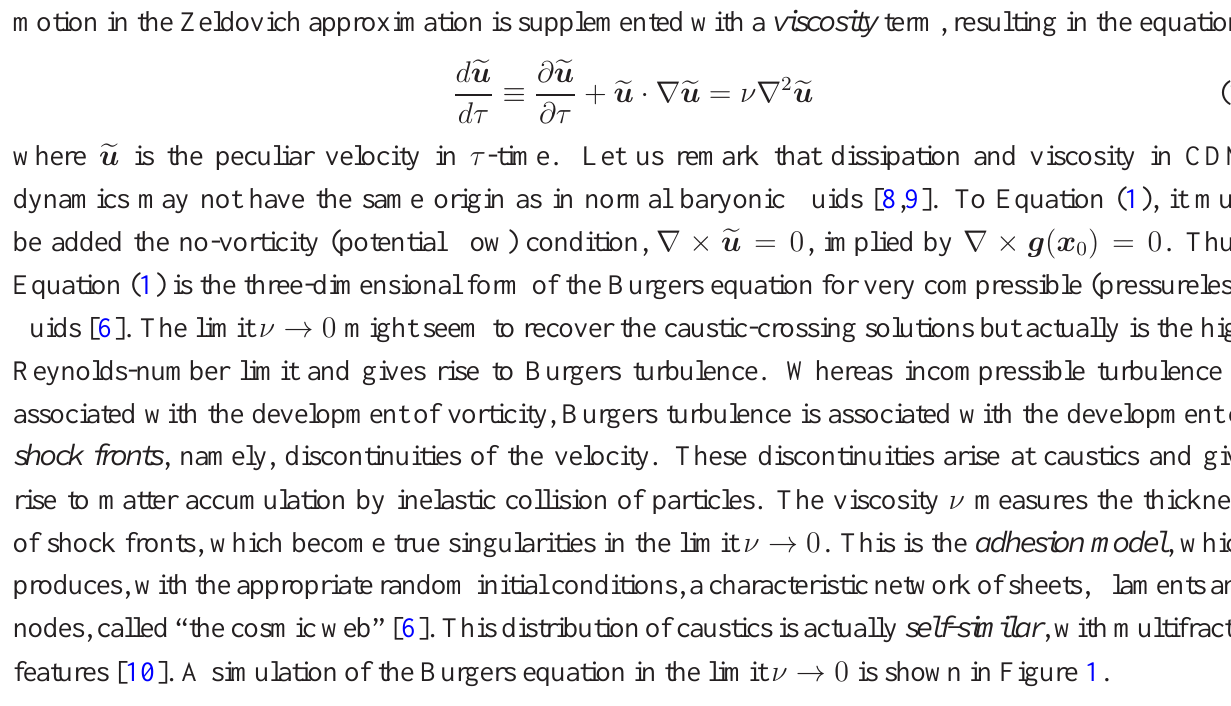
Figure 1. Cosmic web produced by the Burgers equation with random initial